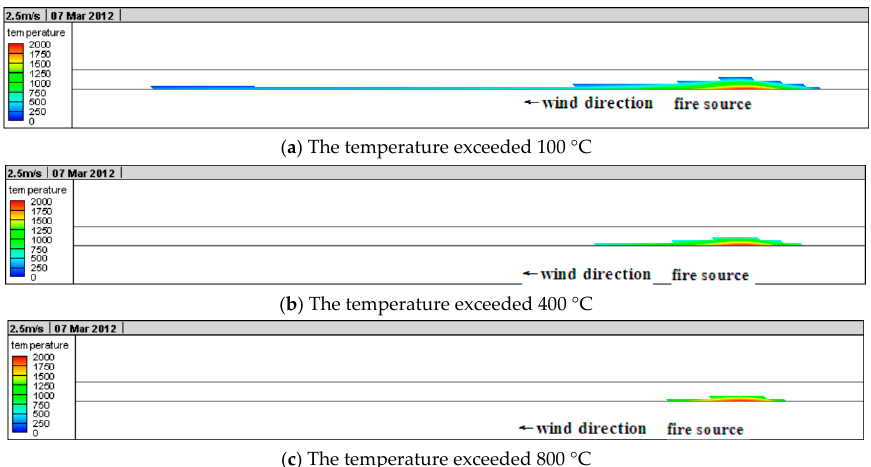
Figure 12. Cross section temperature in the tunnel.